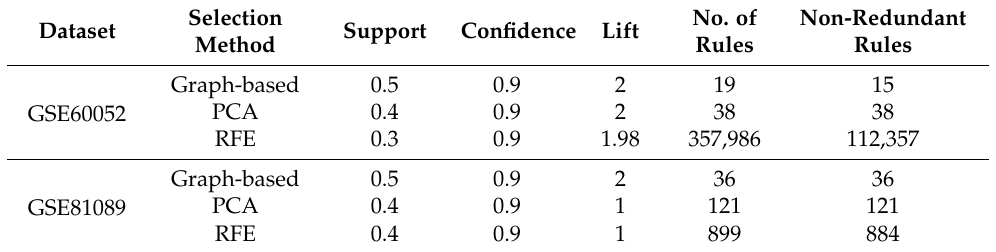
Table 4. Rules generated using Apriori from features selected using different approaches.